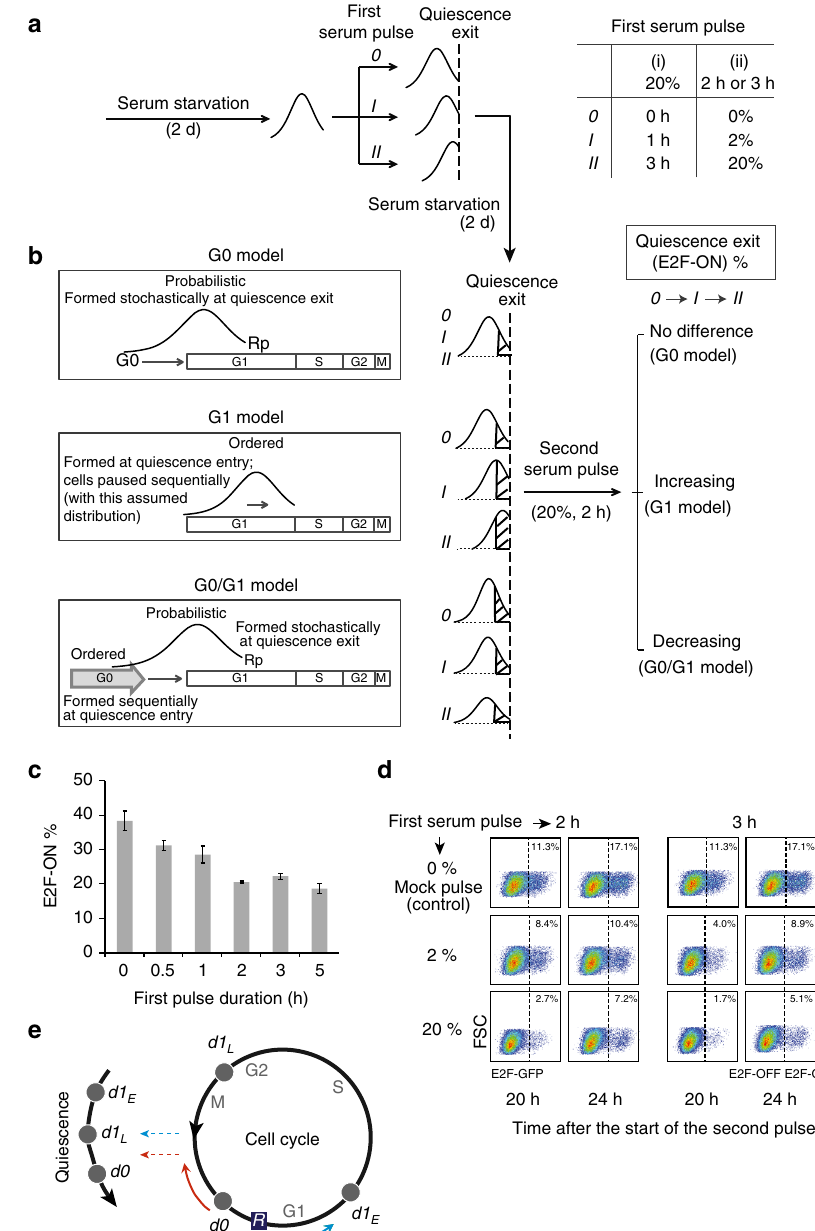
Fig. 5 Experimental tests of three competing quiescence models. a , b Experimental schemes. See text for details. Two sets of fi rst serum pulse with increasing duration (i) or concentration (ii) are shown on the right of a . Three competing models (G0, G1 and G0/G1) for quiescence, with their explanations of quiescence-exit heterogeneity (probabilistic, ordered and both, respectively) are shown on the left in b . Rp , restriction point. c , d Following experimental schemes in a and b , after the fi rst serum pulse of increasing durations (0 – 5 h at 20%, c ) or increasing concentrations (0 – 20% for either 2 or 3 h, d ), cells were returned to quiescence by serum starvation, and then subject to the second serum pulse. Percentages of E2F-ON cells were measured at the 24th hour ( c , mean ± s.e.m. of triplicates) or at the 20th and 24th hour d after the initiation of the second serum pulse. e The new quiescence model. Quiescent cells are located in the G0 state outside of the cell cycle while arrayed in a sequence re fl ecting their preceding cell growth and division, which together with noise in the Rb-E2F bistable system, determines quiescence-exit likelihood ( d0 : non-divided cells, d1 L and d1 E : divided cells previously at late and early cell cycle positions at quiescence induction,